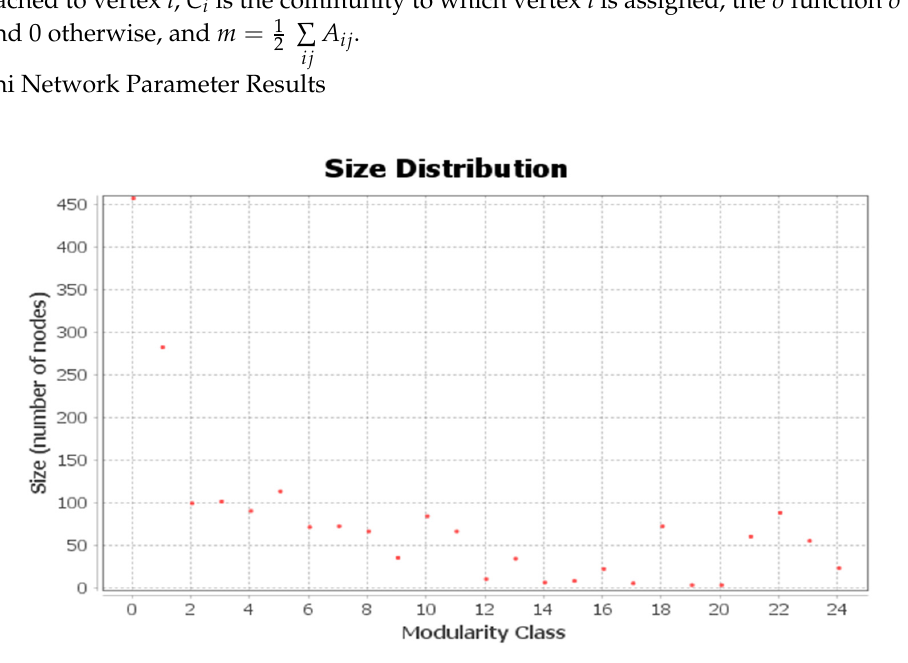
Figure A6. Community size distribution.